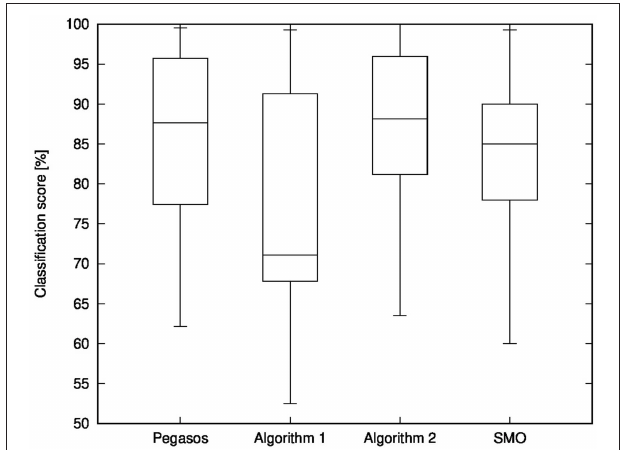
FIGURE 2 | Box-plot comparison of Pegasos, Algorithm 1, Algorithm 2, and SMO Algorithm in terms of classification scores on the test sets.